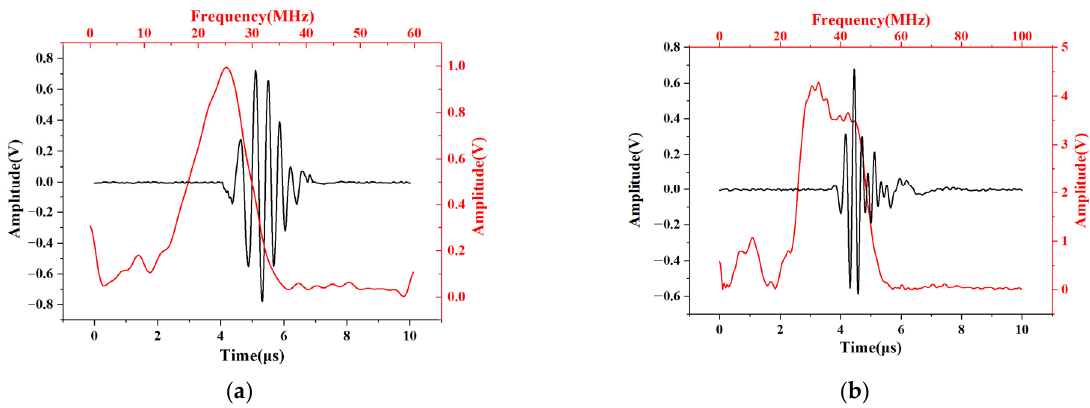
Figure 5. Pulse–echo waveform and frequency spectrum for ( a ) M42 bolt; ( b ) M48 bolt.